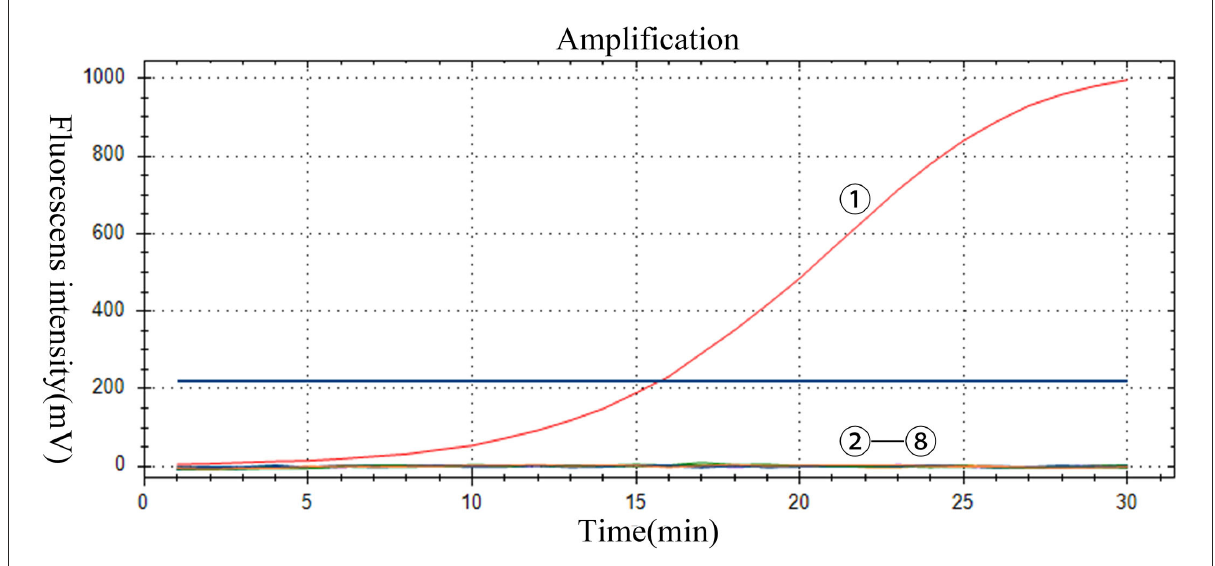
FIGURE4 Specificity of the RT-RAA assay for PoRVA. ‹ - – : PoRVA, PRRSV, JEV, APPV, SVV, CSFV, and GETV virus RNA, respectively; ‡ : negative